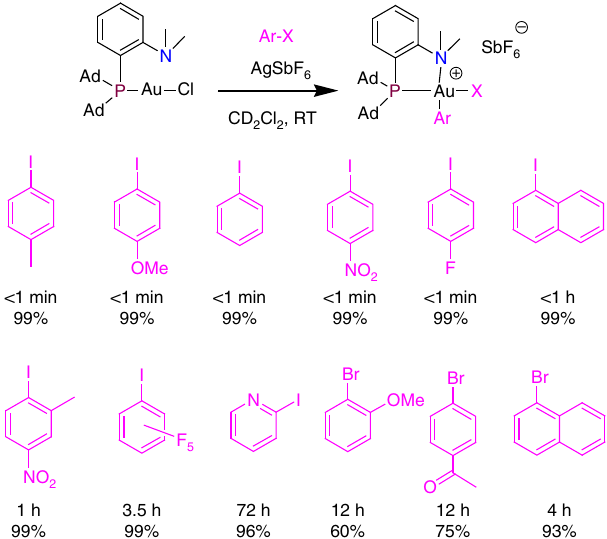
Fig. 4 Oxidative addition of aryl iodides and bromides to gold. Reaction of a series of aryl iodides and bromides with complex 1 in the presence of AgSbF 6 . Reaction times to reach complete conversion and spectroscopic yields are based on 31 P